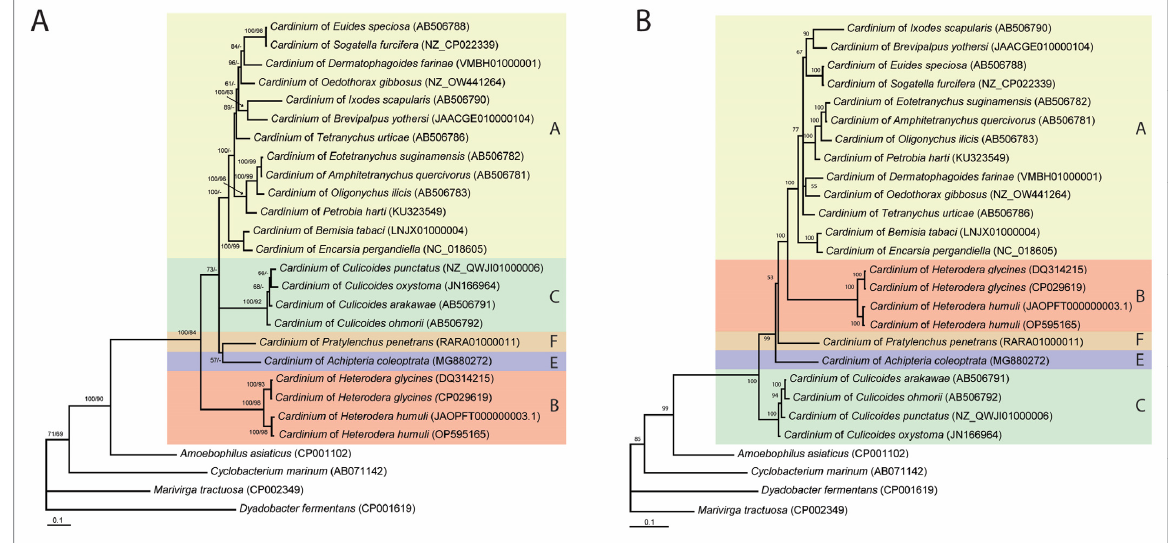
Figure 3. Phylogenetic relationships among representatives of Cardinium clade. Bayesian 50% majority rule consensus trees as inferred from gyrB nucleotide (alignment length ‐ 1414 bp) ( A ) and amino acid (alignment length ‐ 470 aa) ( B ) sequence alignments. Posterior probabilities (BI) and bootstrap values (ML) more than 50% are shown at branching points. A phylogenetic network for the 16S rRNA gene sequences (432 sequences, alignment length ‐ 461 bp) reconstructed using statistical parsimony (SP) and a tree derived from